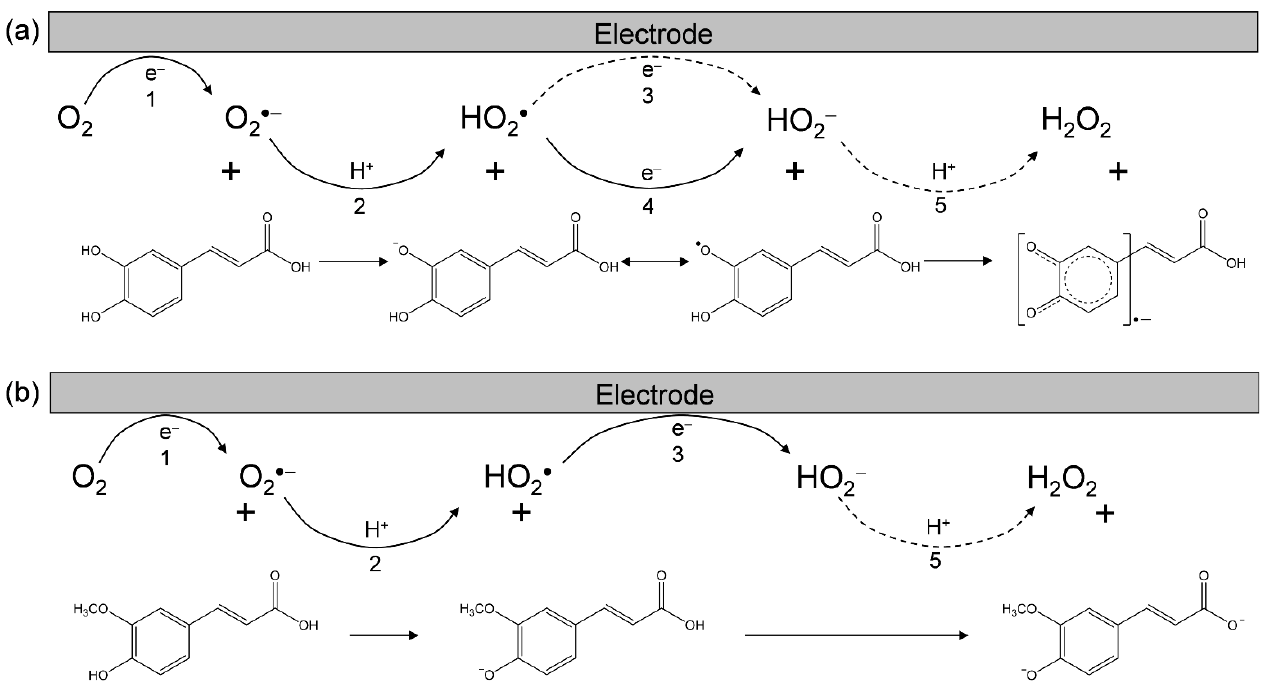
Figure 2. Electrochemical mechanisms of O 2 /O 2• − in the presence of ( a ) CafH 2 (COOH), and ( b ) ferulic acid in DMF. 1 one-electron reduction of O 2 /O 2• − , 2 the initial PT from substrate to O 2• − , 3 exergonic